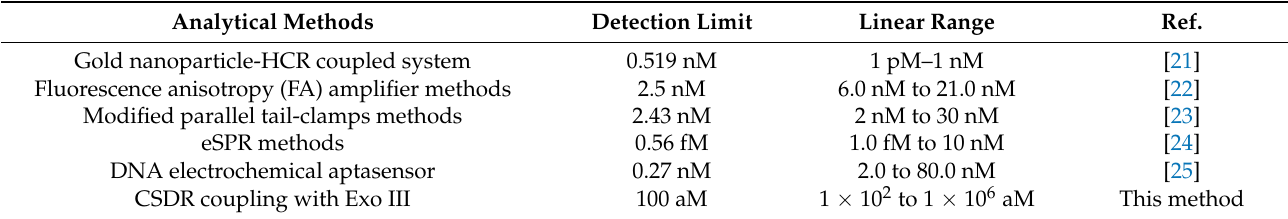
Table 1. Comparison of this biosensor with the reported methods.